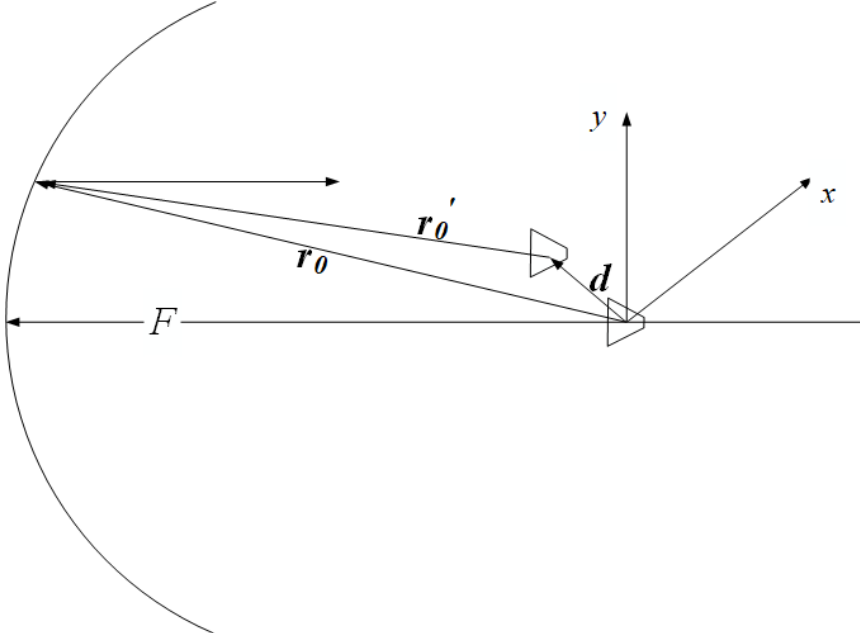
Figure 2. Schematic diagram of the feed displacement of a parabolic